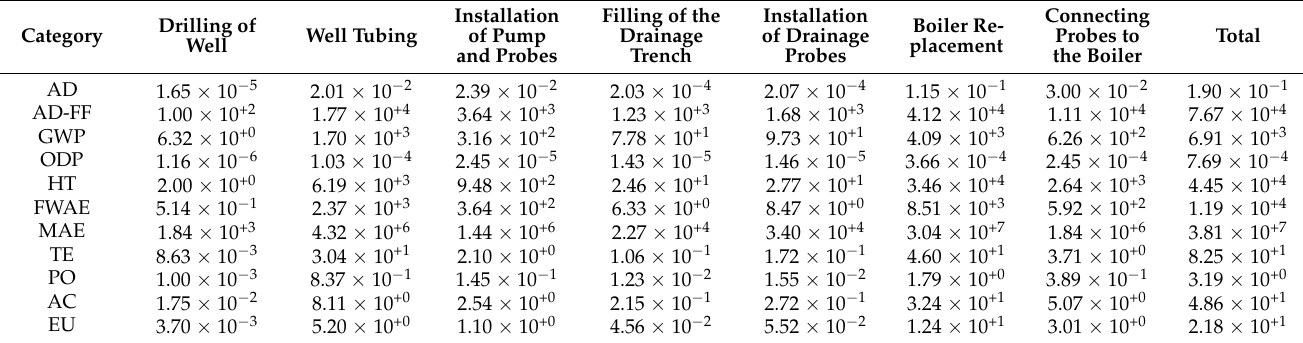
Table 5. Environmental impact by phases for alternative B.